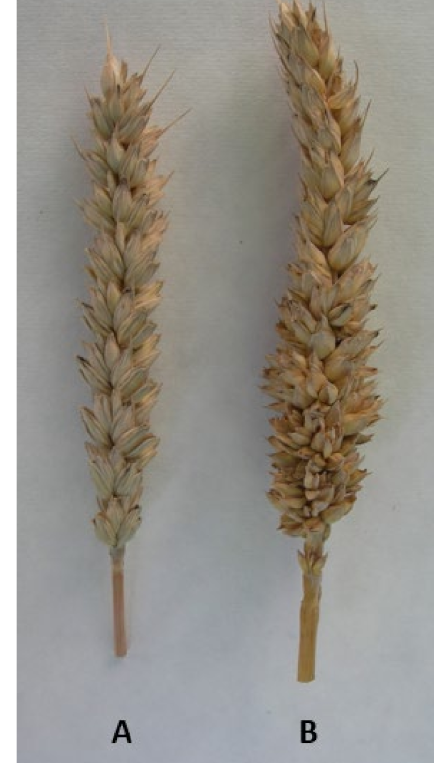
Figure 1. ( A ) Cultivar KM-72-18 (donor of the blue colour aleurone); ( B ) cultivar KM-94-18 (multirow spike